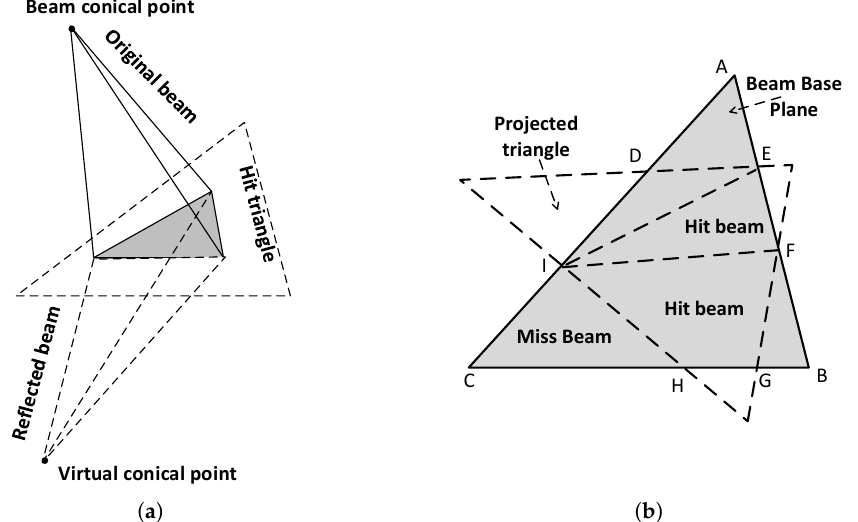
Figure 5. ( a ) The generation of reflected beams. ( b ) The generation of hit beams, e.g., IDE, IEF, IFGH, and miss beams, e.g., CIH, DAE, and